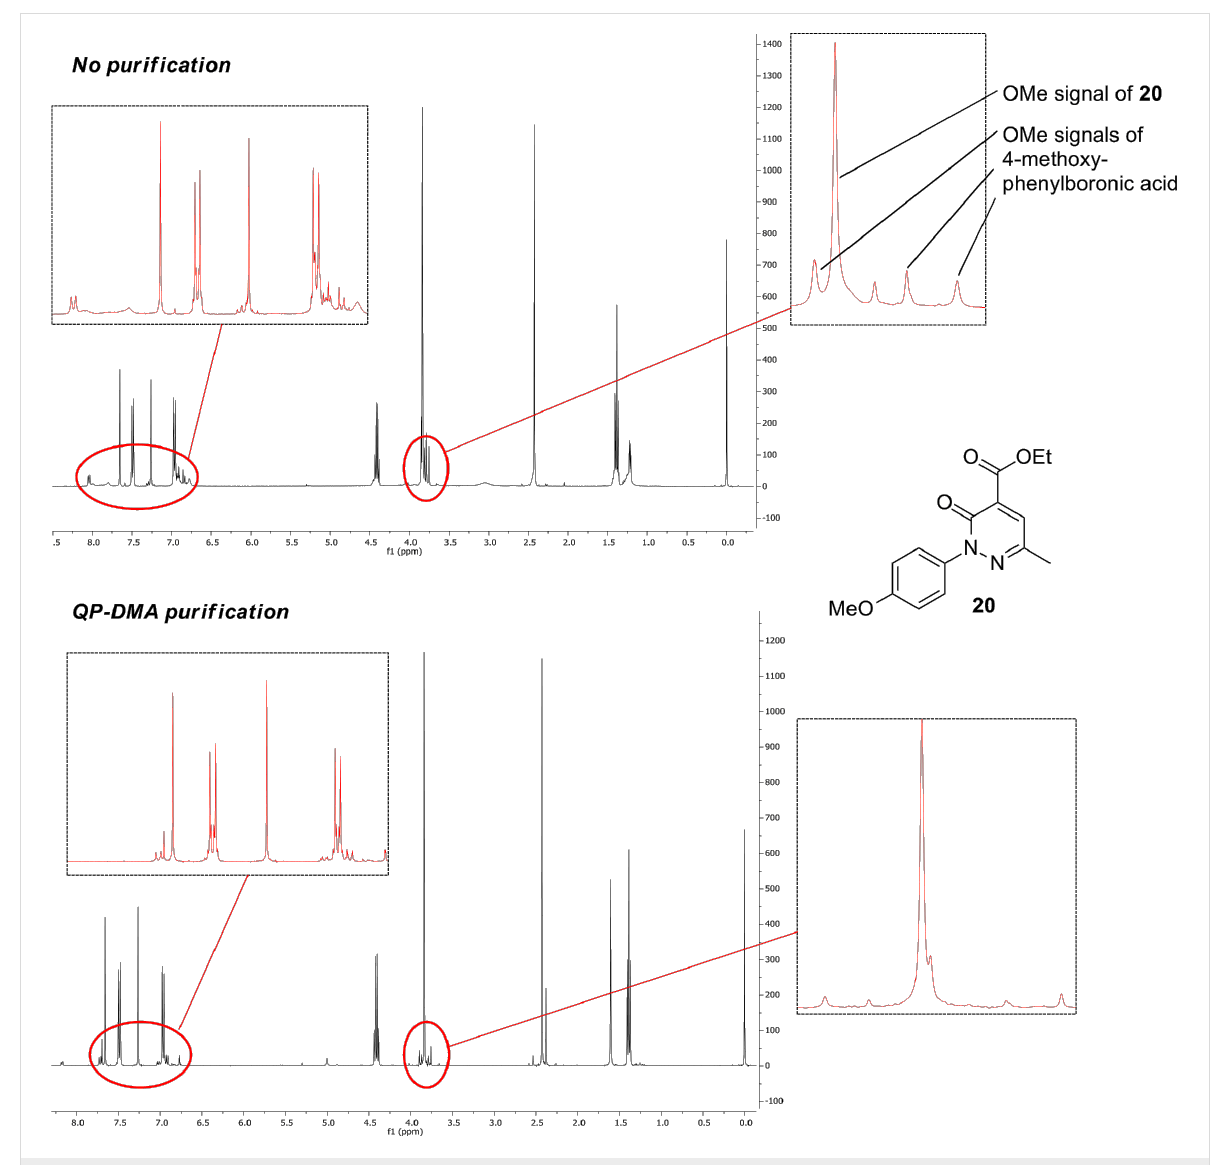
Figure 3: Comparison of 1 H NMR spectra of non-purified (top) and QP-DMA purified (bottom) continuous flow synthesis of compound 20 .